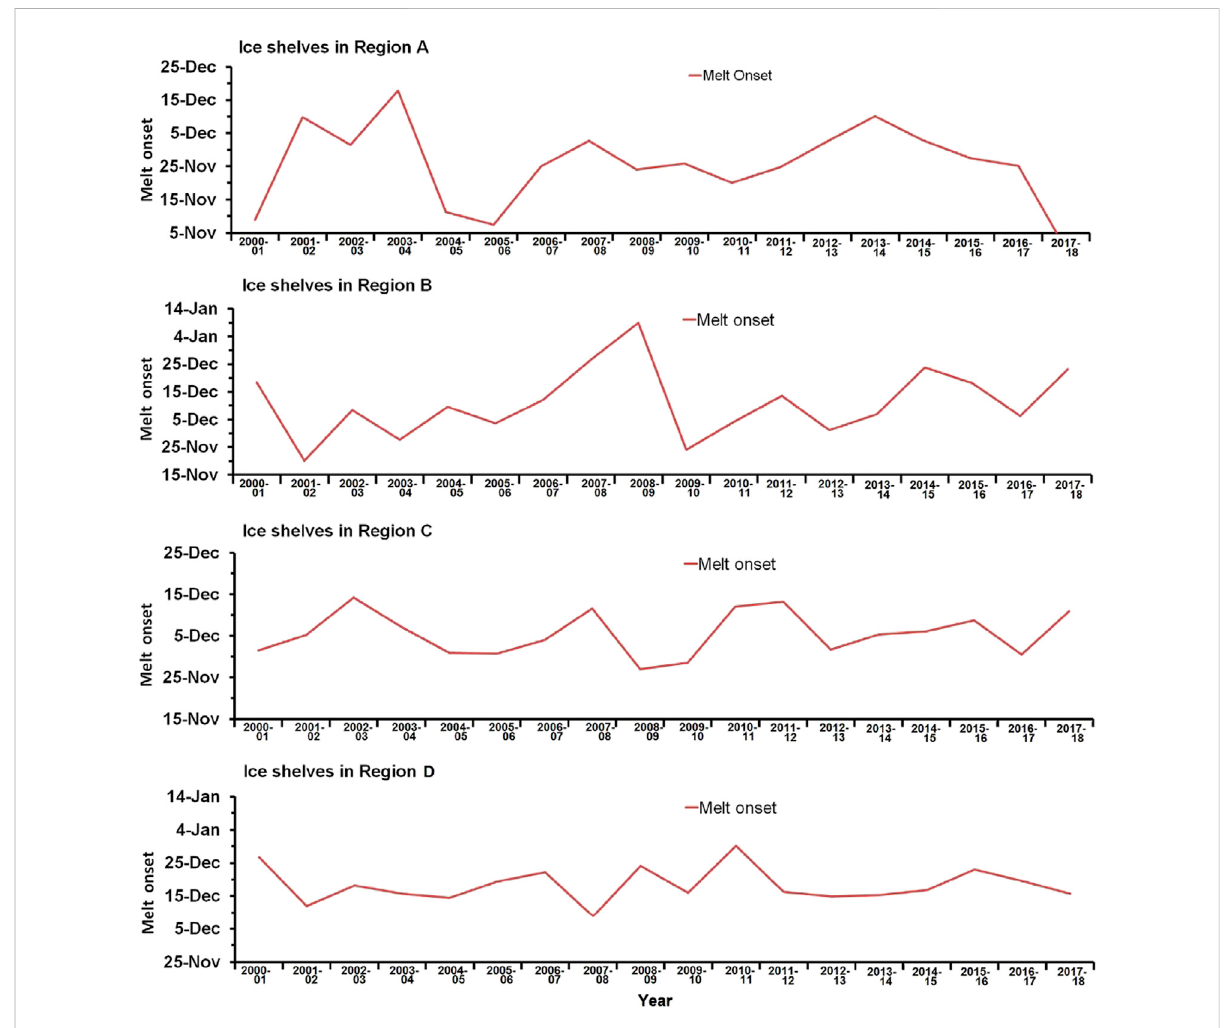
FIGURE 6 Time series of spatial-averaged melt onset at different regions demarcated in Figure